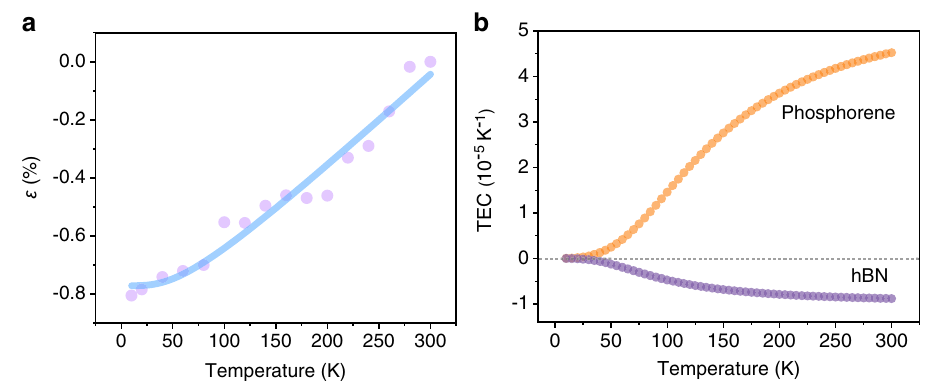
Fig. 6 Thermal parameters of phosphorene and hBN. a Experimentally measured (violet symbols) and theoretically fi tted (blue solid line) intrinsic thermal strain of phosphorene as a function of temperature. b Extracted temperature-dependent thermal expansion coef fi cient (TEC) of phosphorene